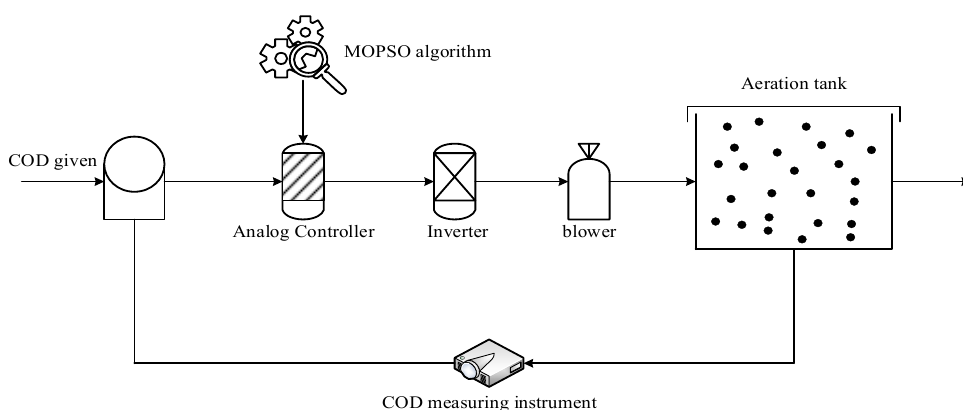
Figure 2. Sewage treatment control system structure diagram.